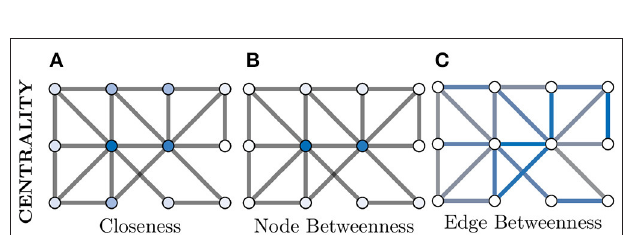
FIGURE 6 | Centrality measures indicate the relative importance of a node within a graph. There are a great number of centrality metrics that make different assumptions and provide different insights, here we provide two example metrics. (A) Closeness centrality gives a relative importance based on the average shortest path between a node and all other nodes. The smaller the average the more important the node (darker blue) and vice versa (whiter). (B) Betweenness centrality is similar but considers how many shortest paths must pass through a node and, in this example, clearly separates the central two nodes (dark blue) as much more important than the other nodes (which appear white). (C) Centrality can also be applied to edges instead of nodes; here more blue indicates a more central role in information flow for an